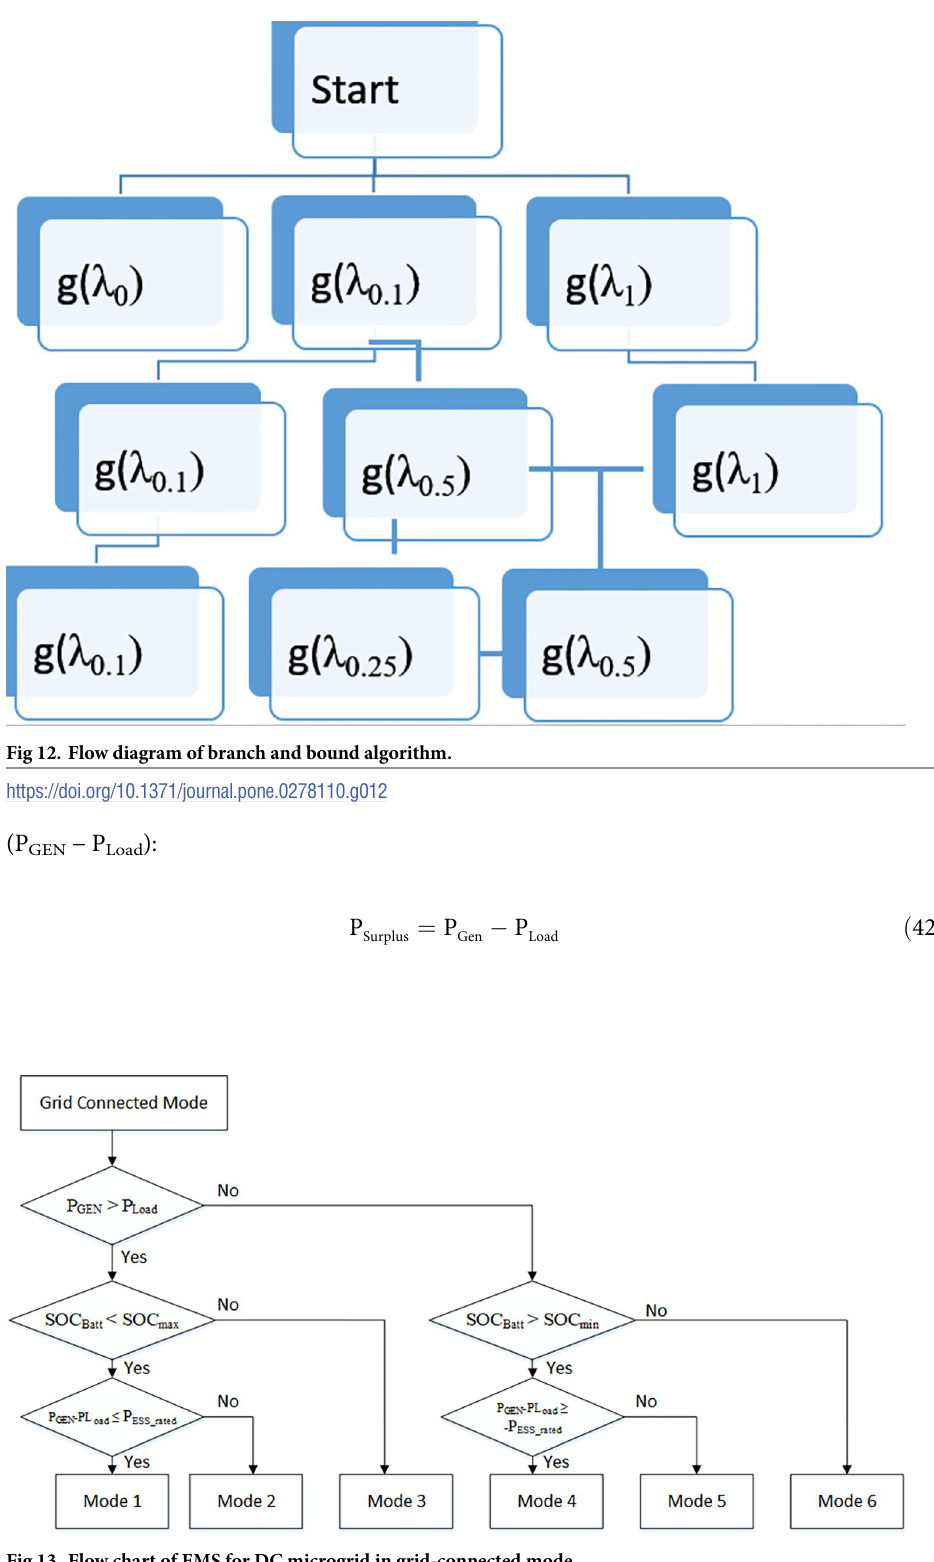
Fig 13. Flow chart of EMS for DC microgrid in grid-connected